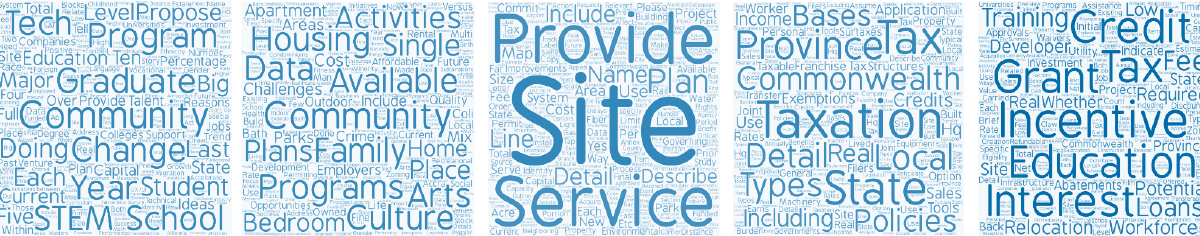
Figure 5. Word clouds of RFI’s 607 items, by section. From left to right: talent, growth, site, taxes and tax policy,